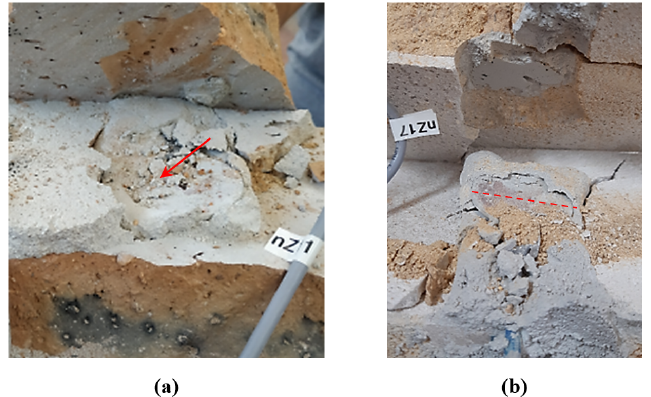
Figure 13. Installation defects: ( a ) discontinuity in the section; ( b ) sensor